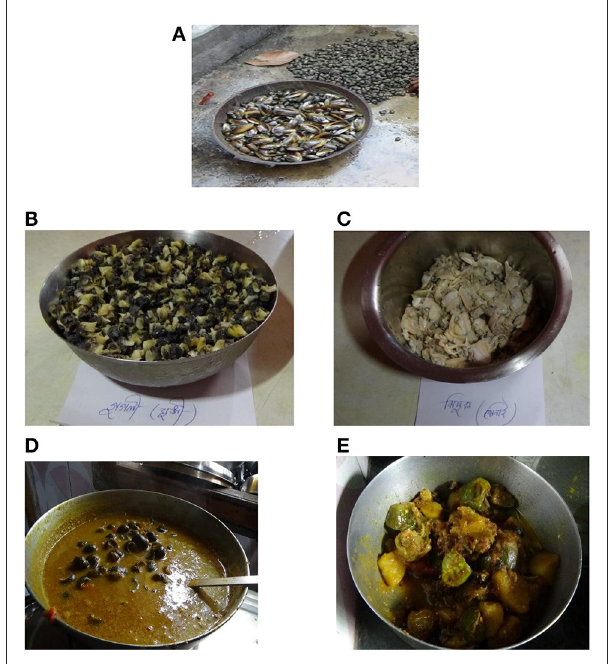
FIGURE2 Protein rich foods: (A) The Ghungi (Common Periwinkles). (B, C) Meat of periwinkles. (D, E) Common periwinkles being cooked in a different way.